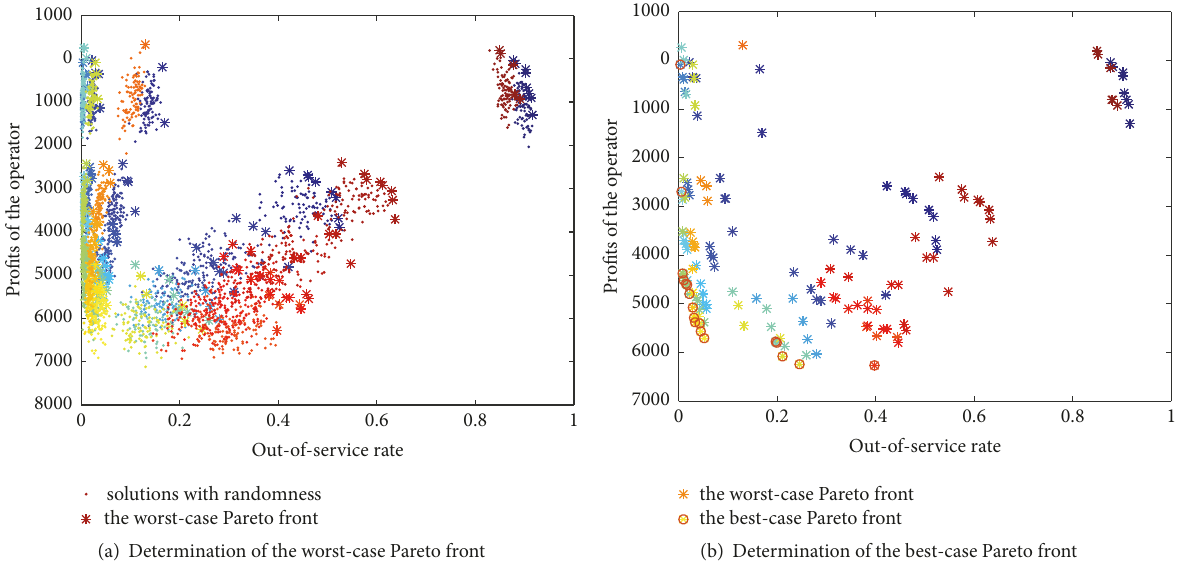
Figure 4: The visualization of the algorithm of the example